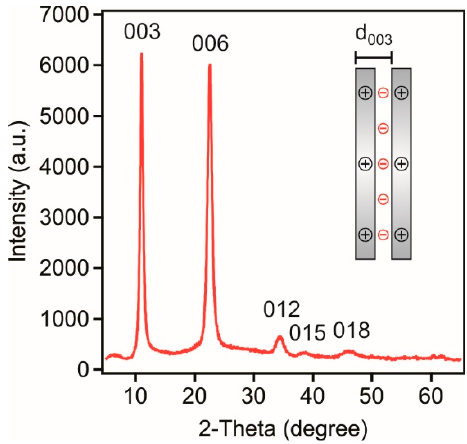
Figure 1. Powder XRD pattern of the LDH particles composed of magnesium(II) and aluminium(III) cations and chloride interlayer anions. The inset illustrates the meaning of the d 003 value calculated from the (003) reflection.